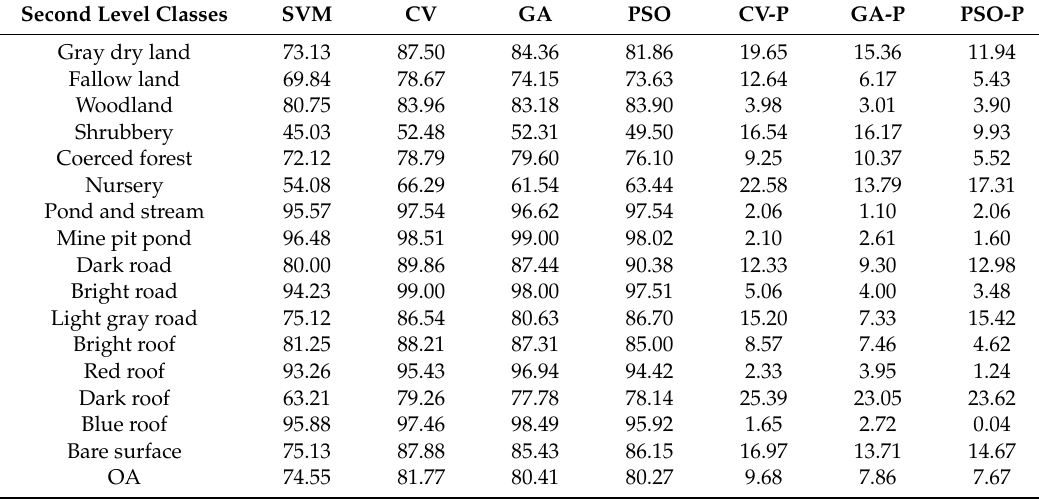
Table 7. McNemar test results for the mapping of open pit mining areas. fij: the numbers of cases that were wrongly classified by classifier i but correctly classified by j (i, j = 1, 2); χ 2: chi-square; p : probability value.